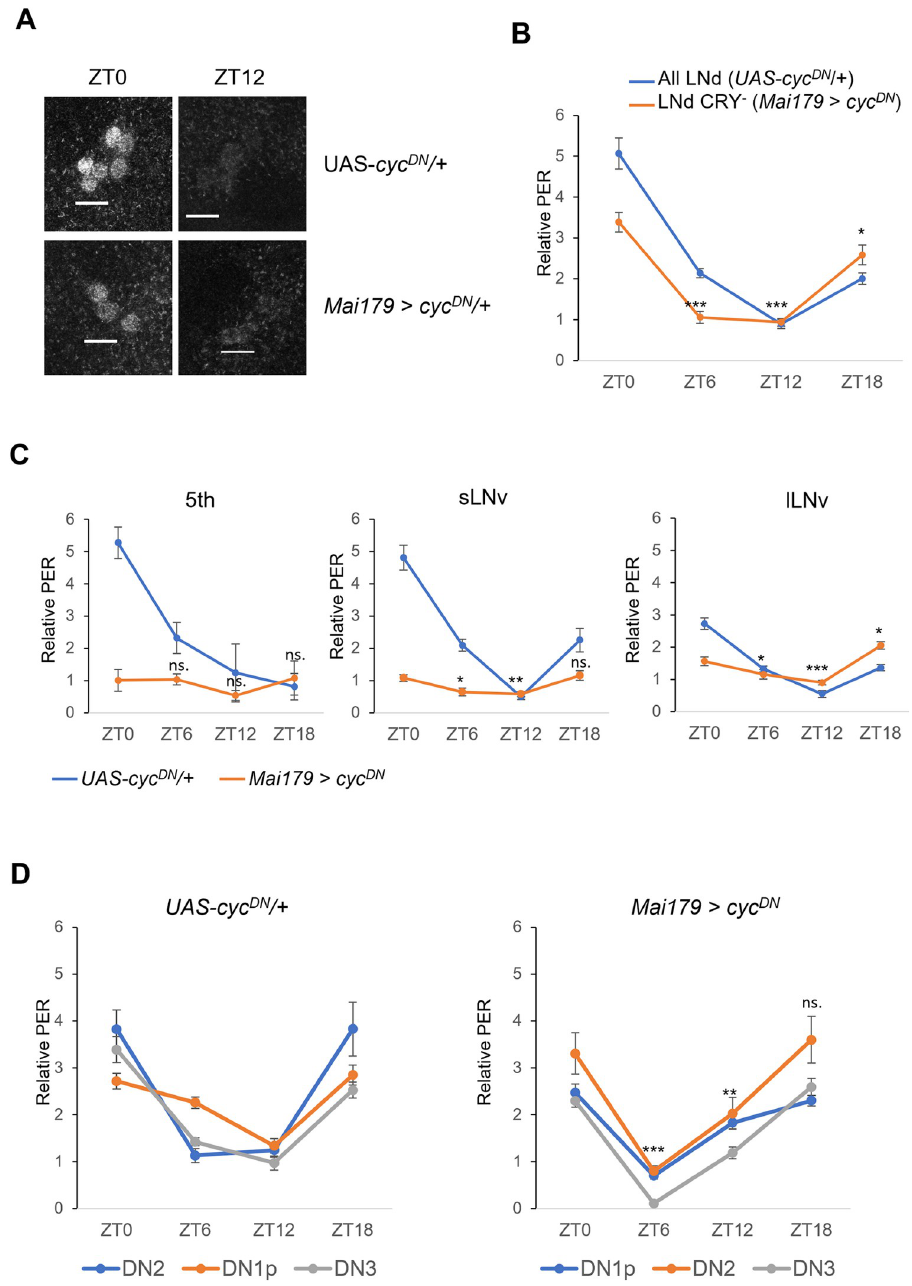
Fig 2. Blocking clock function in Mai179-Gal4 cells does not prevent temperature synchronization of PER expression in other clock neurons. PER immunostaining on the 6 th day of LLTC6. A) PER signals in the LNd at ZT0 and ZT12 in controls ( UAS-cyc DN /+) and Mai179 > cyc DN brains. Scale bar: 10 μ m. B) Average relative PER levels in the LNd. Only the 3 LNd (presumably CRY - ) were visible and quantified in Mai179 > cyc DN brains, while all 6 LNd were quantified in the controls. C, D) Average relative PER levels in the other Lateral (C) and Dorsal Neurons (D).